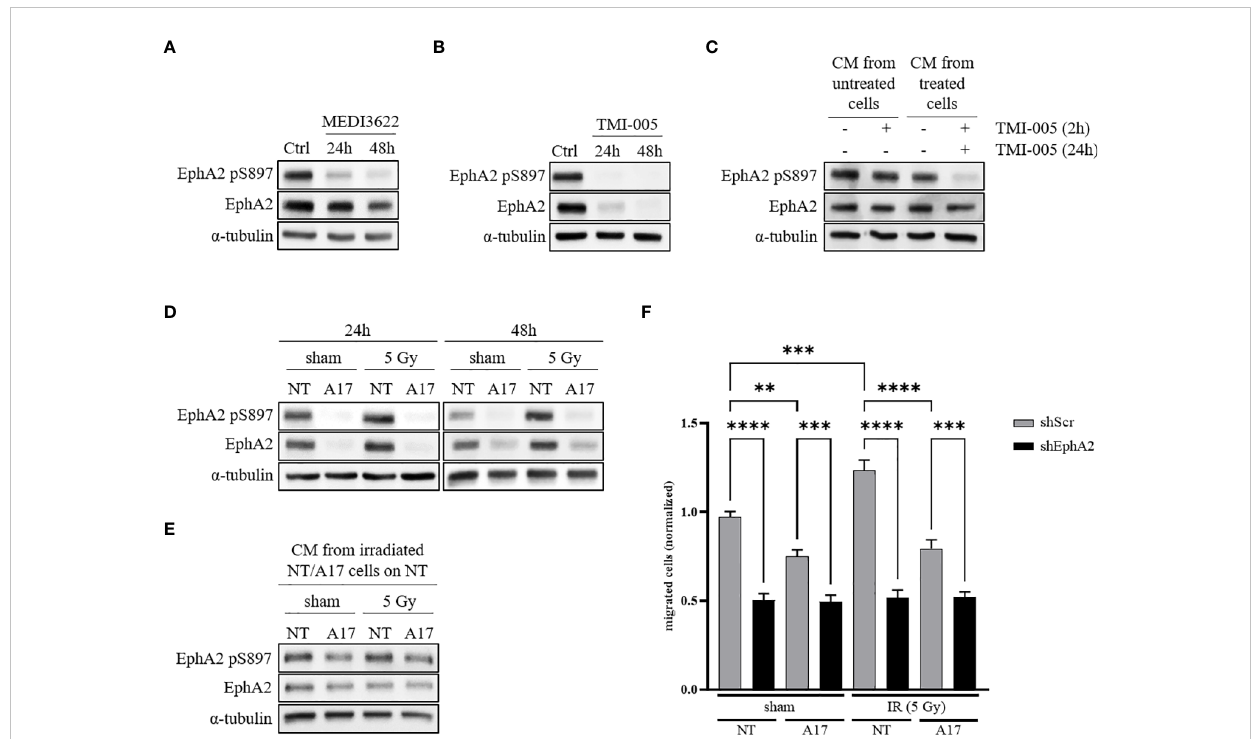
FIGURE 2 ADAM17 activity regulates EphA2 pS897 and total EphA2 levels through auto- and paracrine signaling. (A) ADAM17 inhibition with the mAb MEDI3622 (200nM) abrogates EphA2 pS897 while (B) TMI-005 (25µM) additionally reduces total EphA2 levels. (C) CM derived from untreated and TMI-005 (24h) treated NCI-H358 cells was transferred on naïve NCI-H358 cells to assess the paracrine effect on EphA2 S897 phosphorylation. To exclude the effect of remaining TMI-005 in the CM, cells were additionally pre-treated for 2h with TMI-005 as indicated in the upper treatment row. (D) Protein lysates of NCI- H358 tumor cells transduced with a doxycycline-inducible shRNA system directed against ADAM17 (A17) or control (NT) was used to assess the effect of ADAM17 and IR (24h and 48h post-IR) on EphA2 S897 phosphorylation and total EphA2 levels. (E) CM derived from irradiated and sham-irradiated NT/A17 cells was transferred on naïve cells for 2h to elucidate the paracrine effect of ADAM17 knockdown on EphA2 S897 phosphorylation. For all experiments, a - tubulin was used as the housekeeping control. These fi gures are representative of several independent experiments. (F) CM derived from NT/A17 NCI-H358 cells was used to assess the effect of ADAM17 for attracting migrating tumor cells. Bar graphs represent the average number of migrated cells counted in three randomly chosen fi elds/transwell of three independent biological replicates. **, P < 0.01; ***, P < 0.001, ****, P < 0.0001. For all